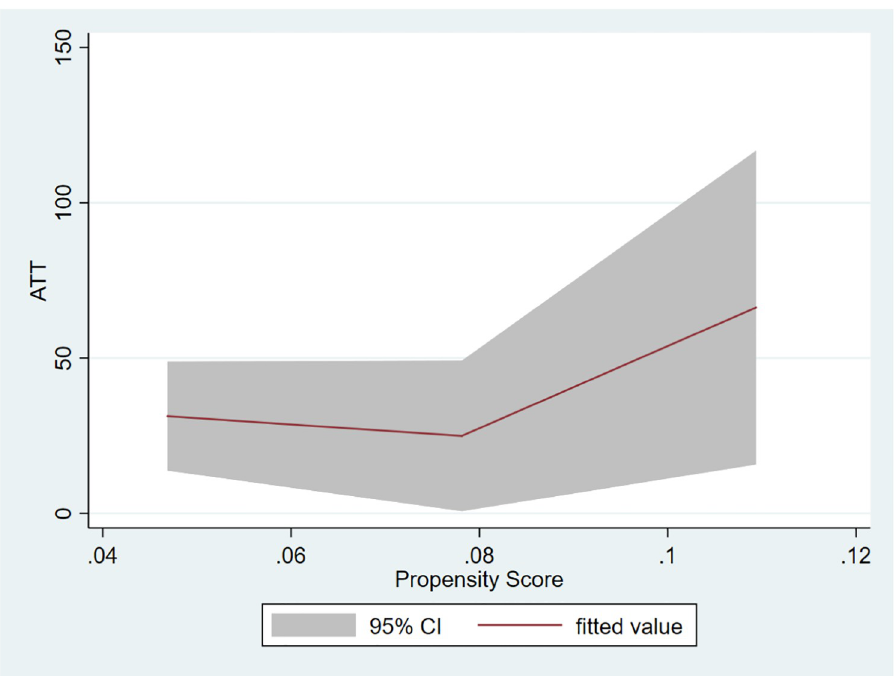
Fig 3. Heterogeneity of impact of the Community Fisheries program (ComFishIII) on biodiversity. Positive values of Average Treatment on the Treated (ATT) indicate an increase in biodiversity.